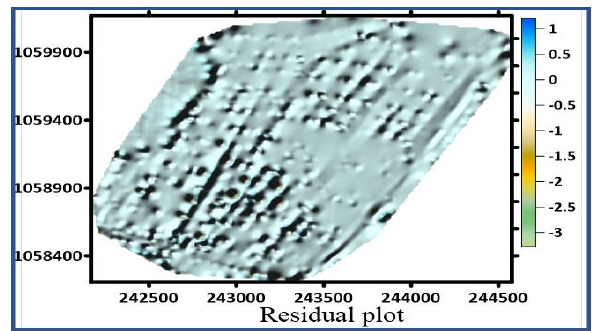
Figure 8. Residual plot of “estimated - observed” unit in Meter. Figure 9 is the digital elevation model (DEM) of Scenarios A, B, C, and D; it describes the reservoir bed configuration. The present cubic content of leapfrog at rest (A) was calculated to be 93,129,808 m 3 , which is 23.79% of the total volume, as shown in Table 2. Subsequently, in Table 2 are the enhanced volume of other stages. Scenarios B and C account for 1.16% and 1.25% increases in volume above the present stage (A). Either B or C can be achieved by dredging or erecting an embankment around the dam of 2 m at any instant. Similarly, D is the combination of Scenario B and C, while A remains constant. Stage D has the edge over B and C of 2.43%, which is a 9,502,144 m 3 increment above the present stage when implemented.